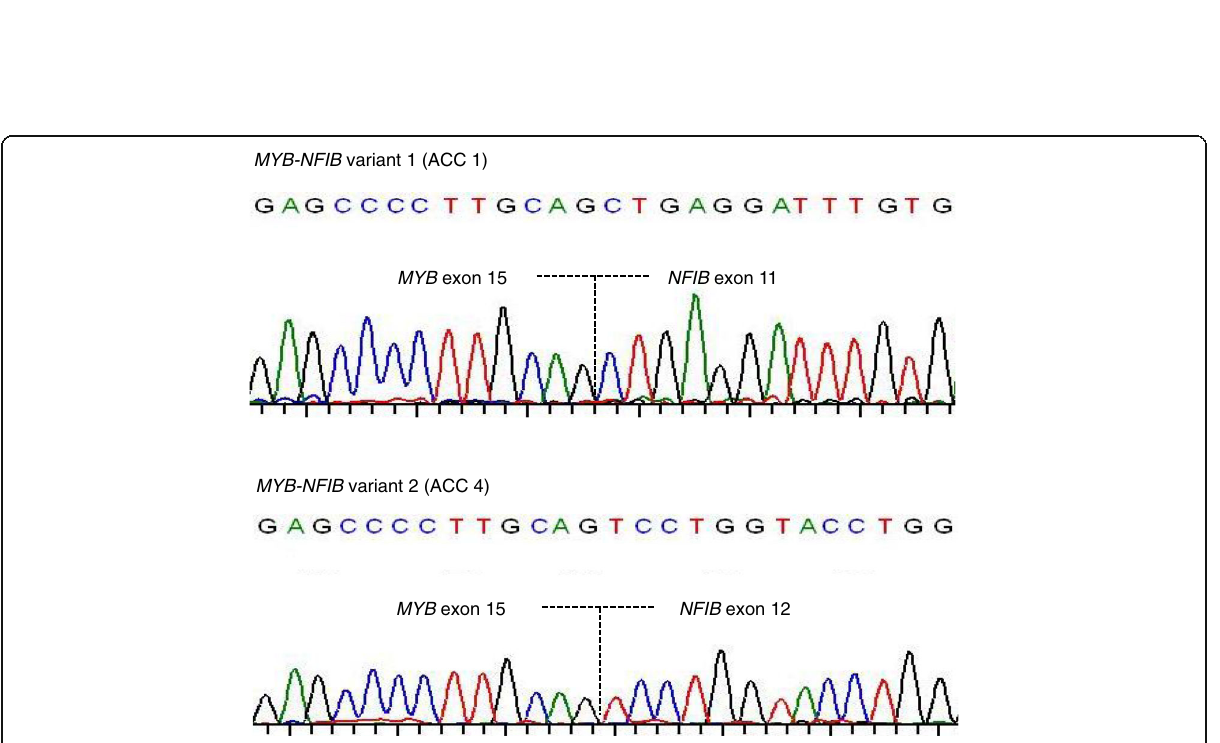
Fig. 4 Representative sequencing profiles of MYB-NFIB variants 1 and 2 detected in fusion positive ACC patients. MYB nucleotide sequence and exon data is based on transcript accession number ENST00000341911 in the Ensembl database and NFIB sequence and exon information is based on Ensembl transcript accession number